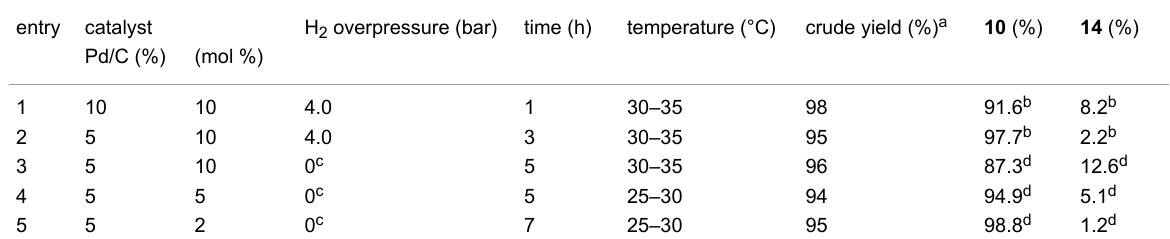
Table 1: Screening of reduction conditions ( 9 → 10